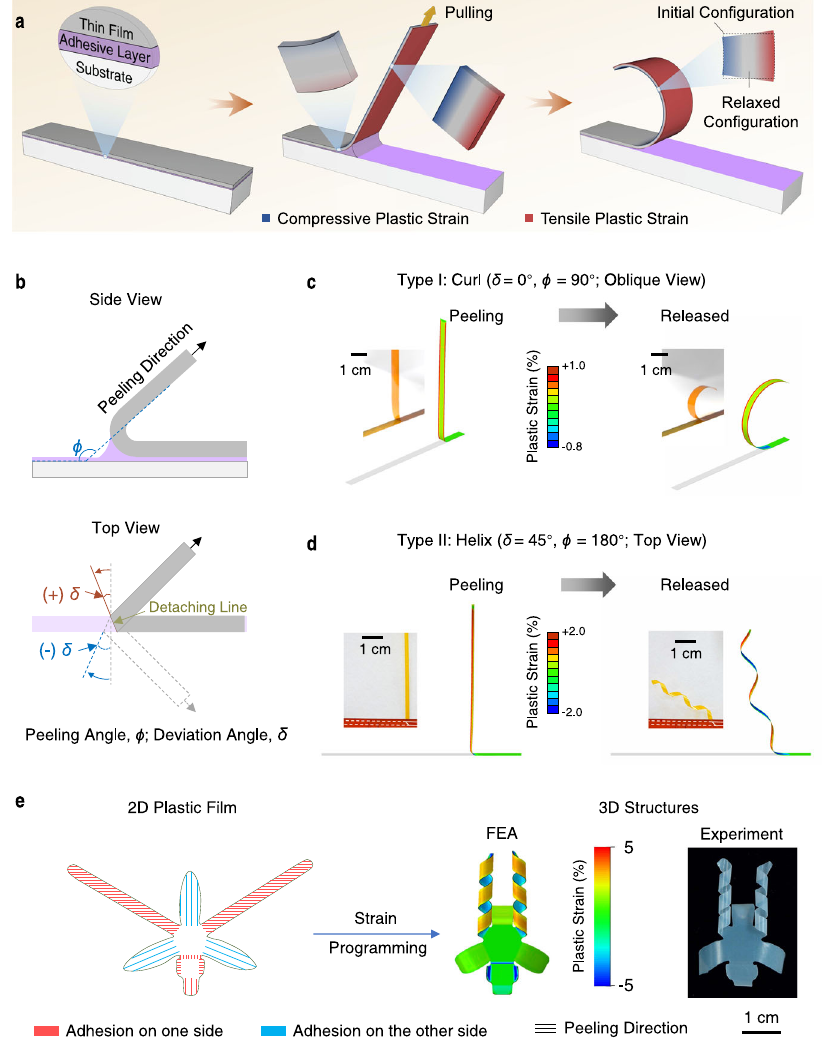
Fig. 1 | Mechanism of peeling-induced shape morphing of plastic fi lms. a Schematicshowingthepeelingprocessinvolvingtheadherentthin fi lm,adhesive layer,andsubstrate.Thethin fi lmisbentatthedetachingareacausingasymmetric deformation (tension and compression) on the two sides. The asymmetric plastic strain remains in the fi lm after releasing and leads to the bending of the fi lm. b Schematic showing two important control parameters: the peeling angle, ϕ , indicates the supplementary dihedral angle between the detached part and adheredpartoftheplastic fi lm;thedeviationangle, δ ,indicatestheanglemeasured from the short axis of the adherent fi lm to the detaching line. According to the